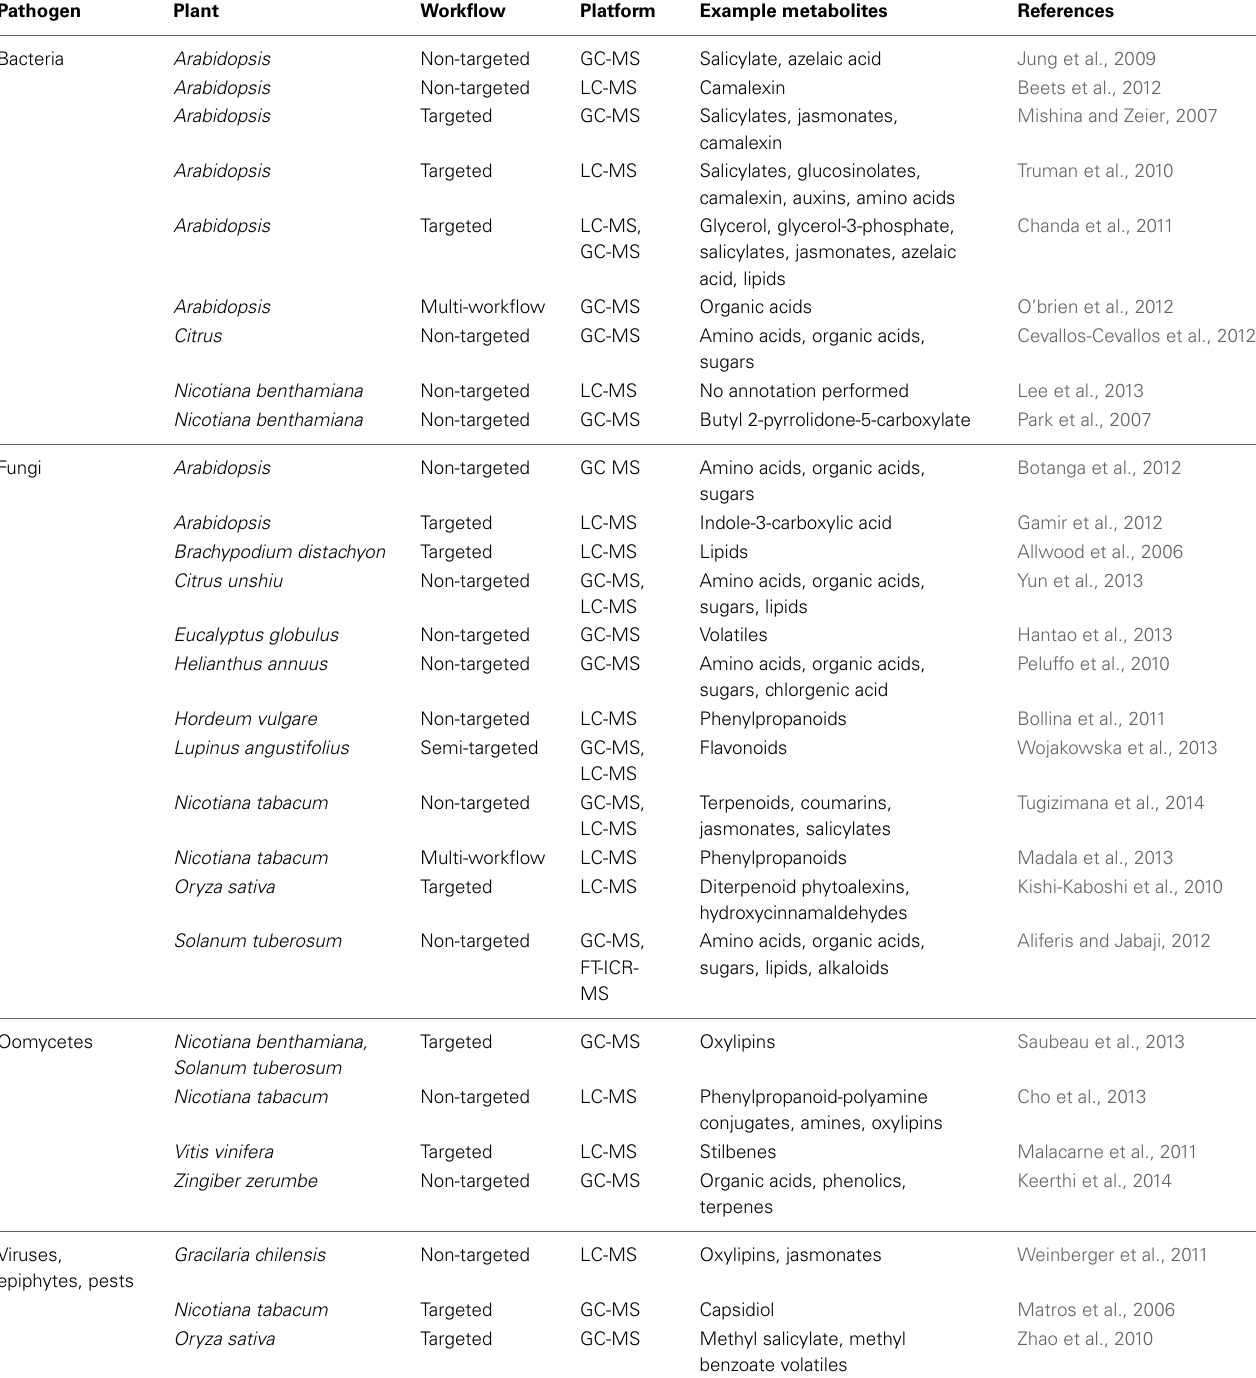
Table 1 | Subset of MS-metabolomic studies with workflows, platforms, and example plant metabolites associated with disease.